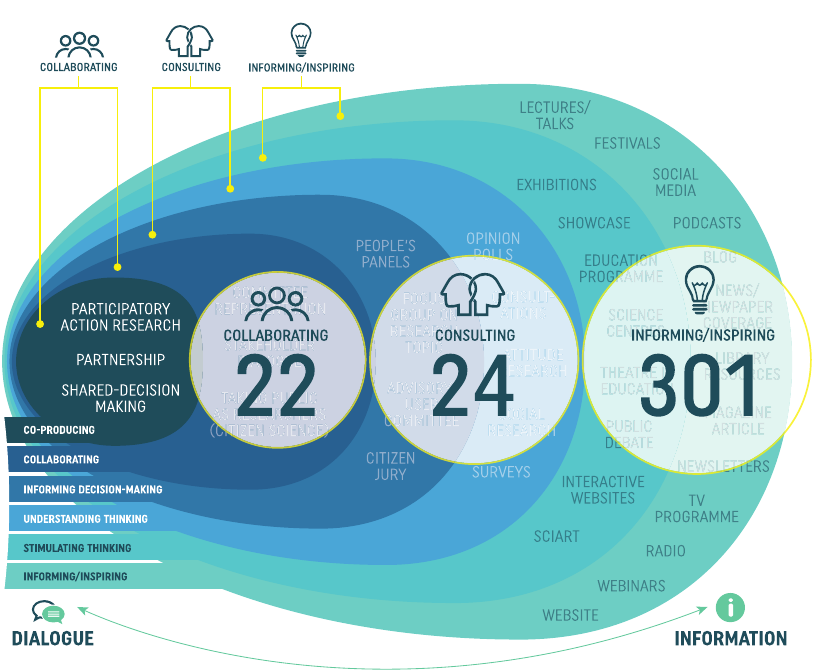
figure 2: Number of references to different forms of public engagement under way in UcD, 2015–20 (source: UcD Public engagement Working Group,